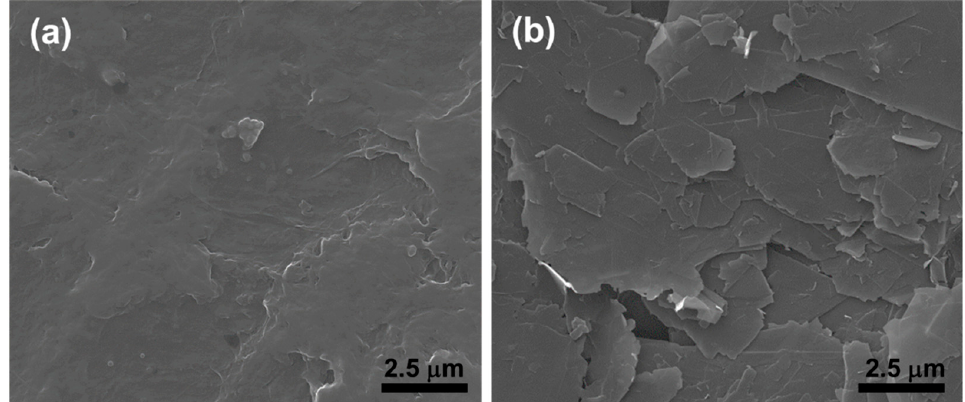
Figure 1. SEM micrographs of low-density polyethylene (LDPE) surface ( a ) and of the coating layer deposited on LDPE ( b ). deposited on LDPE ( b